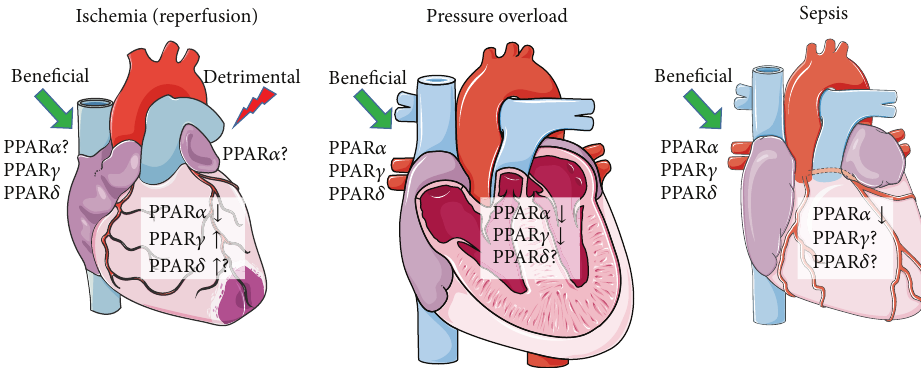
Figure 2: Effect of PPAR activation during cardiac dysfunction. Administration of PPAR agonists has generally been found to have beneficial effects on cardiac function during ischemia (with reperfusion), pressure overload induced hypertrophy, and sepsis-induced cardiac dysfunction. However, the role of PPAR 𝛼 activation in ischemia reperfusion (I/R) injury is unclear as both beneficial and detrimental effects have been reported. Figures were produced using Servier Medical Art (http://www.servier.com).